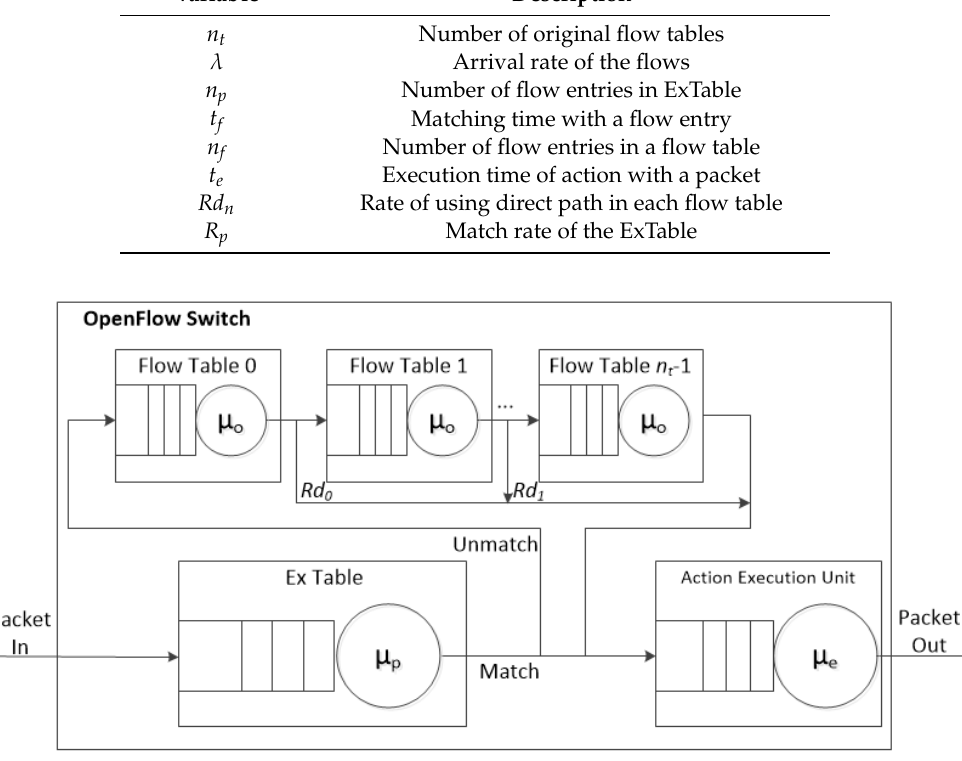
Figure 5. The queuing model of the proposed scheme.